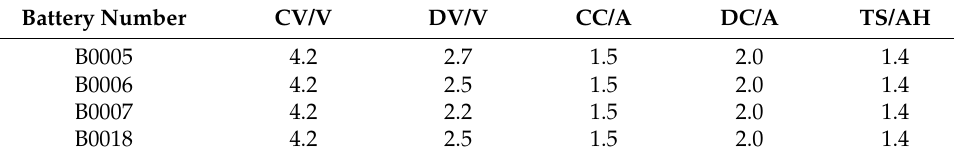
Table 1. Battery parameters in aging experiment.